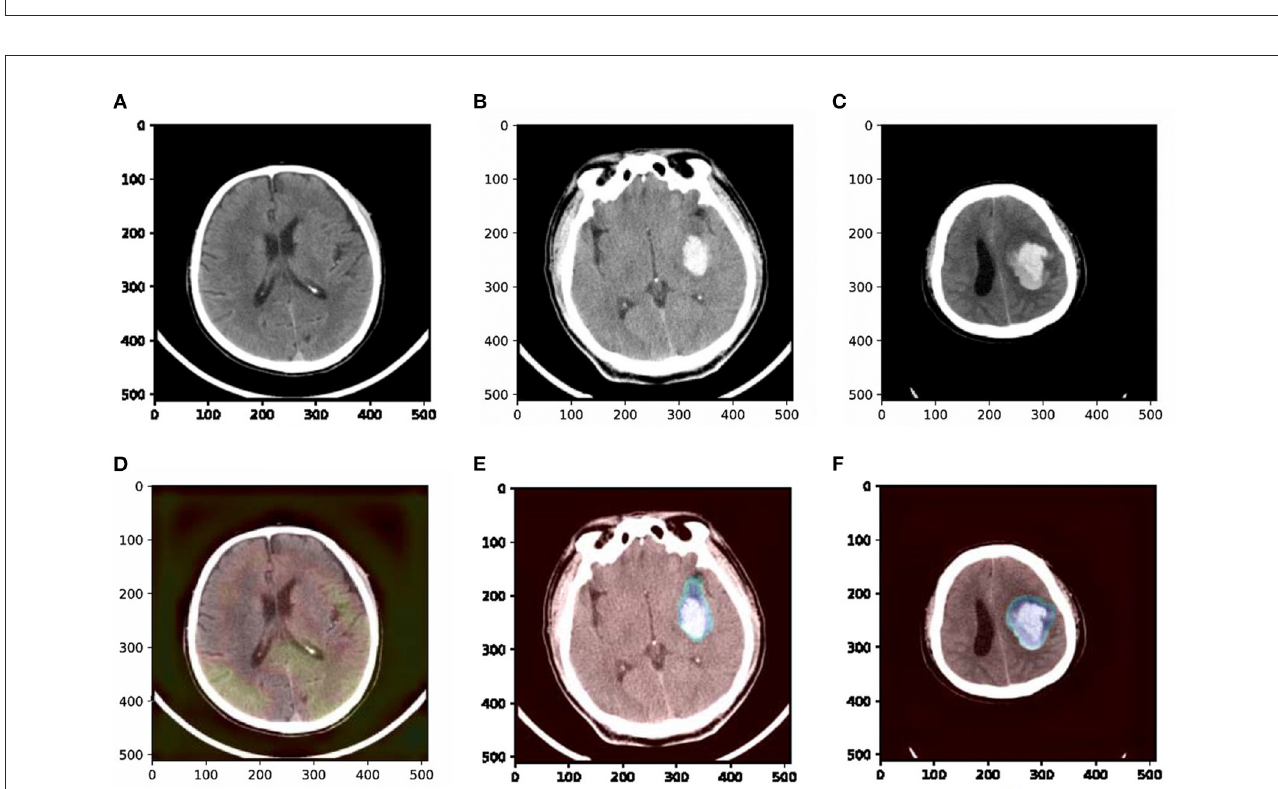
FIGURE7 Examples of original slices with their corresponding class activation heatmaps. (A) Original slice of non-ICH, (B) original slice of normal ICH, (C) original slice of blend sign, (D) class activation heatmaps of the original slice of non-ICH, (E) class activation heatmaps of the original slice of normal ICH, and (F) class activation heatmaps of the original slice of blend sign. It is interesting to note that the regions with hemorrhage are strongly activated, and this is probably how the network can make